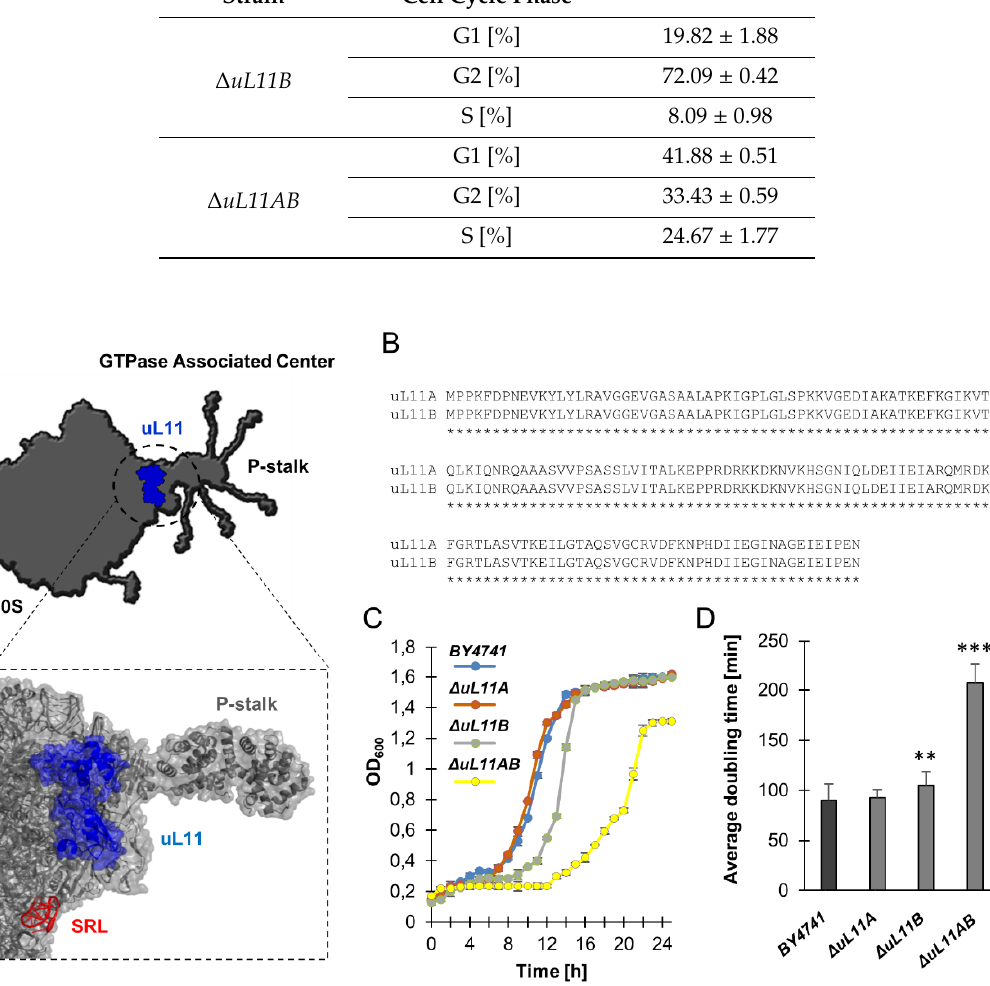
Figure 1. Structural and phenotype overview of yeast ribosomal ∆uL11A and ∆uL11B mutants. The model shows the position of the uL11 protein within the GTPase-associated center in the 60S subunit (PDB code 4V6I); rRNA and proteins are indicated as light gray and dark gray colors, respectively. The fitted schematic structure of the uL11A protein is marked in blue. The P-stalk depicts the position of ribosomal P-proteins and uL10 protein ( A ). Amino acid sequence alignment of uL11A and uL11B proteins ( B ). Comparison of growth kinetics on YPD liquid medium ( C ) and average doubling time during reproduction ( D ). Error bars represent standard deviations obtained from three independent experiments. Statistical significance was assessed using ANOVA and Dunnett’s post hoc test (** p < 0.01; *** p < 0.001) compared to the